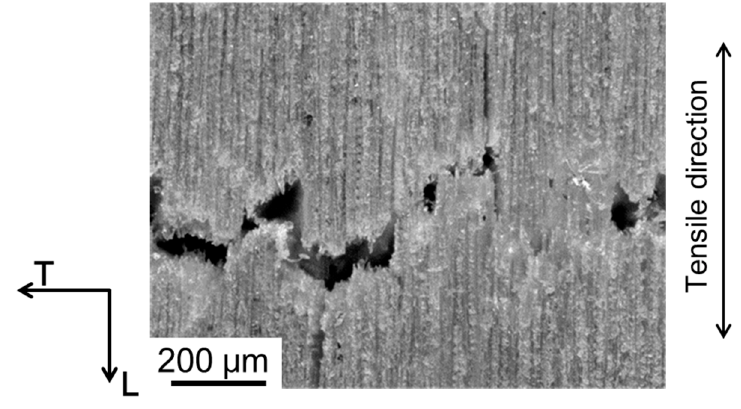
Figure 11. Serrated crack path in the tensile fracture observed in the L-T plane.